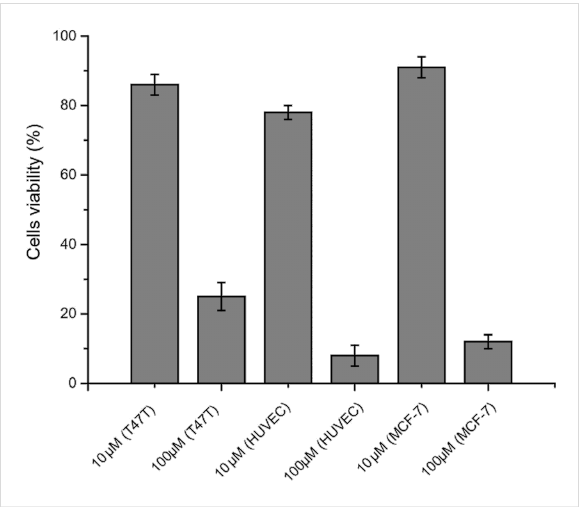
Figure 5: Cellular viability determined by MTT analysis after 24 h treat- ment with the developed dye BTD-4APTEG. No statistically significant cytotoxic effect was observed after 24 h incubation with the new dye BTD-4APTEG at 10 μ M. However, the dye induced strong cytotoxic effects in all tested cell lines at 100 µM ( p < 0.05).